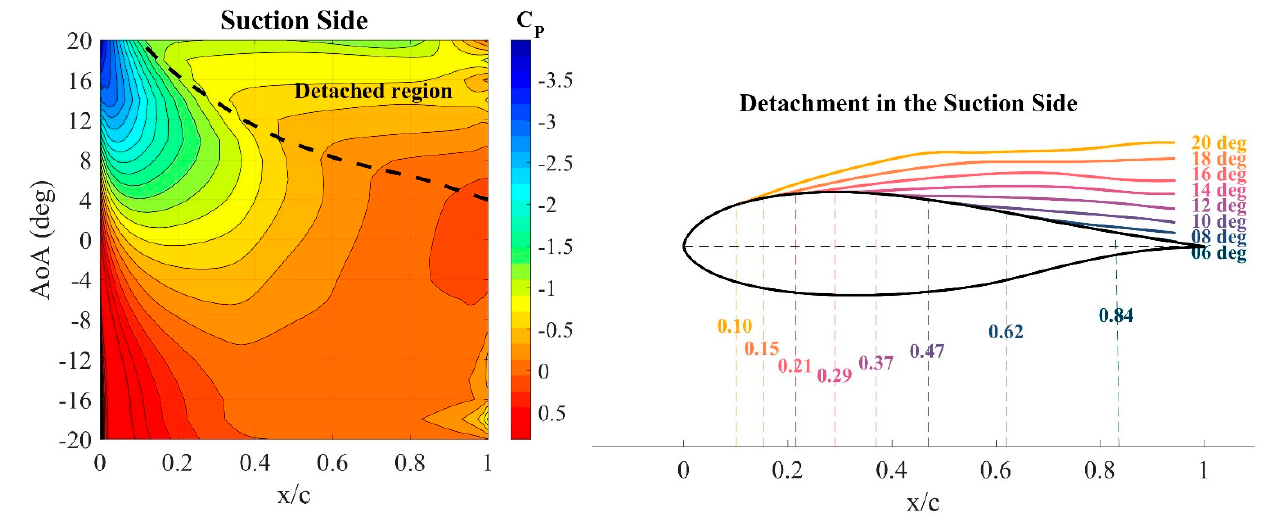
Further insight is now provided with a closer look to the detached regions of the airfoil suction side during a complete oscillation cycle. For that purpose, the longitudinal distribution of the mean pressure coefficients on the suction side of the airfoil is shown in a contour plot in Figure 11, for all the angles-of-attack simulated. A black dashed line identifies the averaged position of the separation point, revealing the severe engrossment of the detached region towards the leading edge for high pitching angles. Moreover, the contour map is complemented by a comprehensive view of the averaged detached regions over the airfoil, for AoA going from 6° to 20° (right plot), in order to illustrate the recirculation zones (identified with negative streamwise velocities).